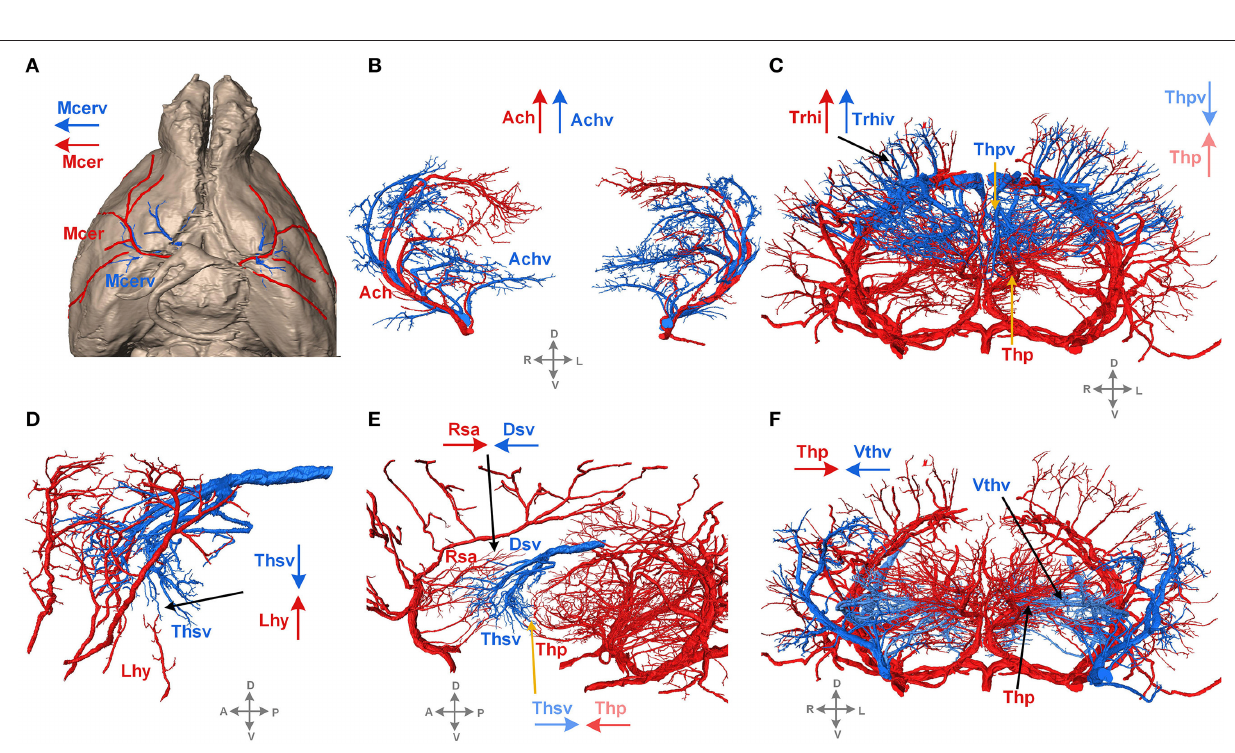
Frontiers in Neuroanatomy | www.frontiersin.org